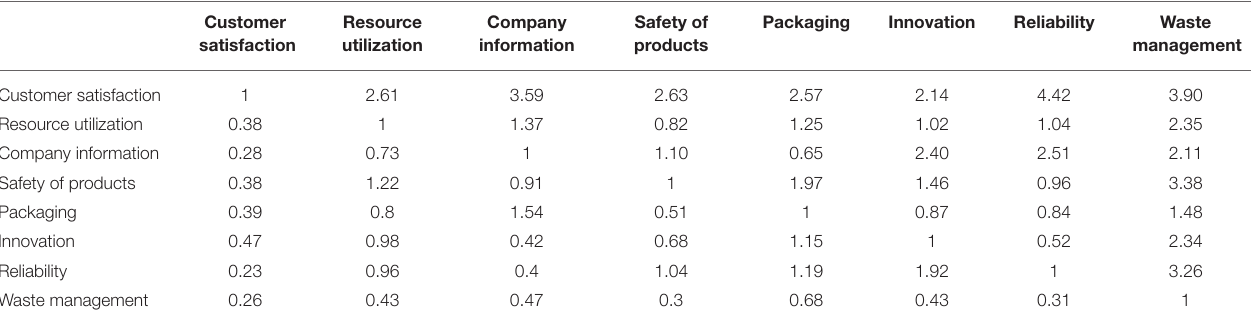
TABLE 6 | Comparison matrix generated by